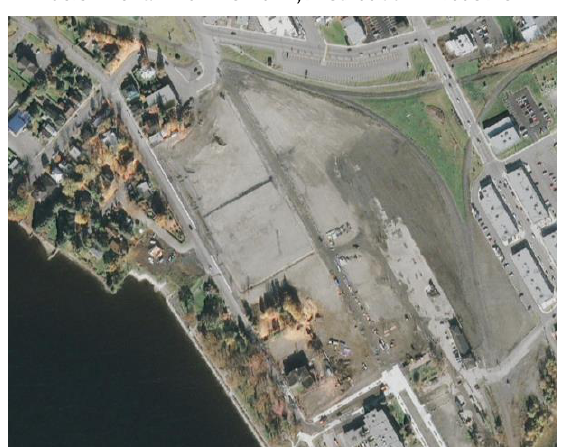
Figure 20. This Pléiades image Acquired on November 3, 2014 illustrates the progress of the remediation 16 months post- derailment. © CNES 2014, Distribution Airbus DS